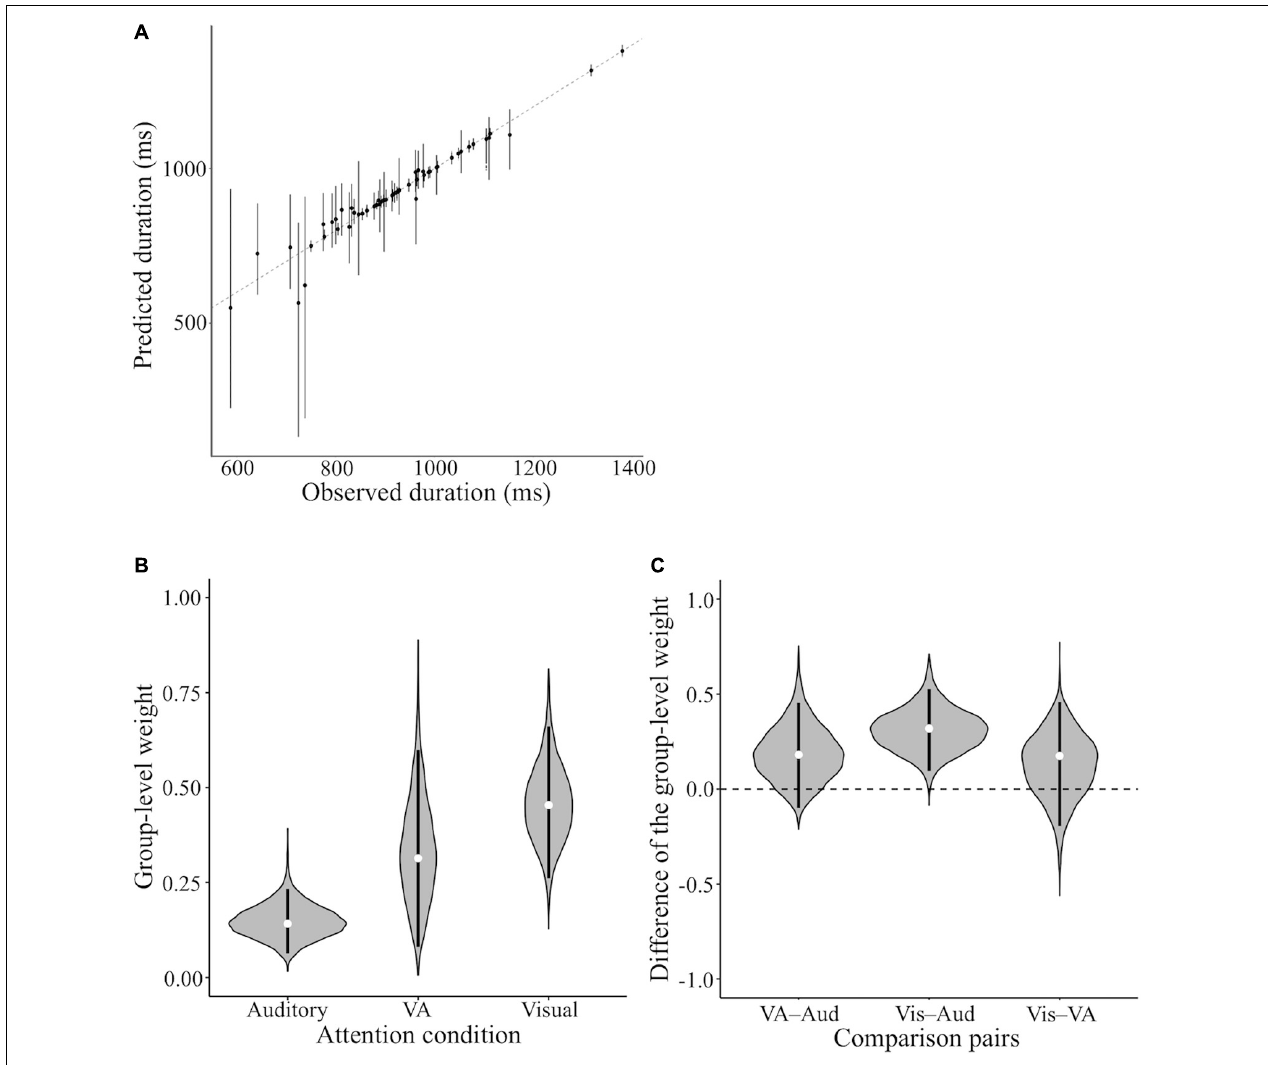
FIGURE 8 | Results of the model assuming the weight by attention. (A) The actual and predicted PSE. The black dot indicates the mode of the simulation in each subject and condition. The black line indicates 95% highest-density-interval (HDI). The dotted line indicates the predicted PSE equal to the actual PSE. (B) The posterior distributions for the group-level weights ( µ a ) in each condition. The white dot indicates the mode of the posterior distribution. The black line indicates 95% HDI. (C) The posterior distributions for the difference of the group-level weights ( µ a ) across attention conditions. The white dot indicates the mode of the posterior distribution. The black line indicates 95% HDI. Vis, Aud, and VA represent visual, auditory, and VA attention conditions, respectively. Comparison pairs represent the difference between each attention condition (i.e., Vis–Aud represents the difference between visual and auditory attention